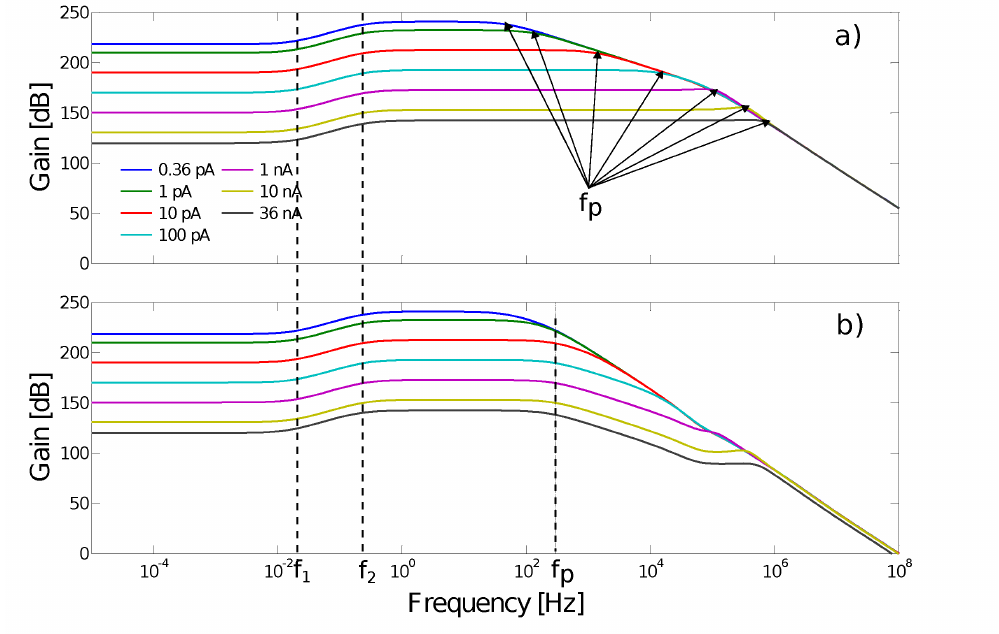
( a ) Simulated photodetector Bode diagram: the values of the low cut-off frequencies f and f are a function of the resistivity of the adaptive element, whereas the 1 2 cut-off frequency f depends on the value of the photodiode’s background current ( I p higher the illuminance is, the higher the frequency f after the integration of the low-pass filter: the cutoff frequency f regardless of the ambient